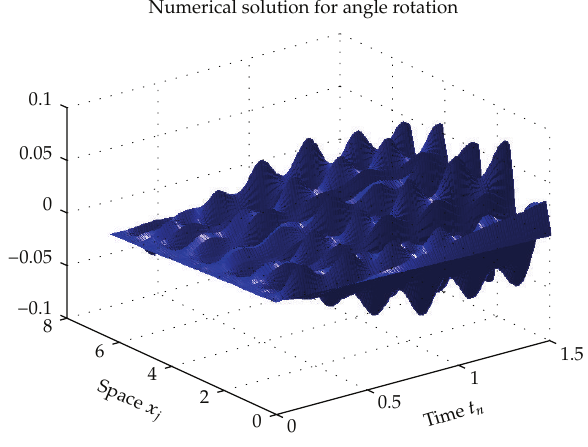
Figure 8: Conservative case, μ (cid:8)